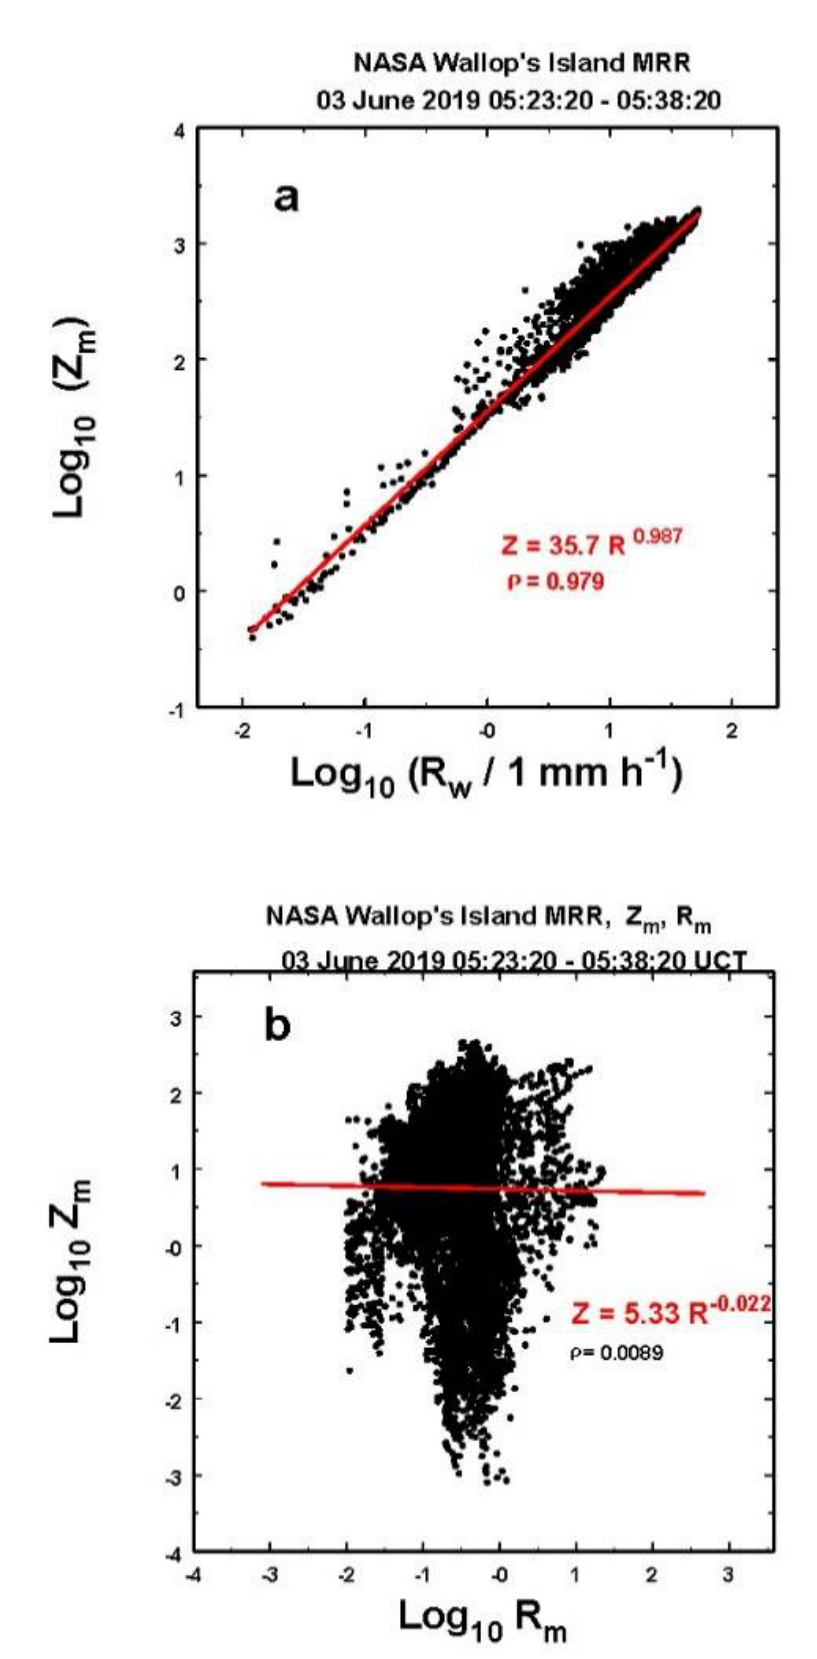
Figure 11. Z–R correlations derived ( a ) for the rainfall rates adjusted for vertical air speed and ( b ) those from the MRR processor, as discussed further in the text.